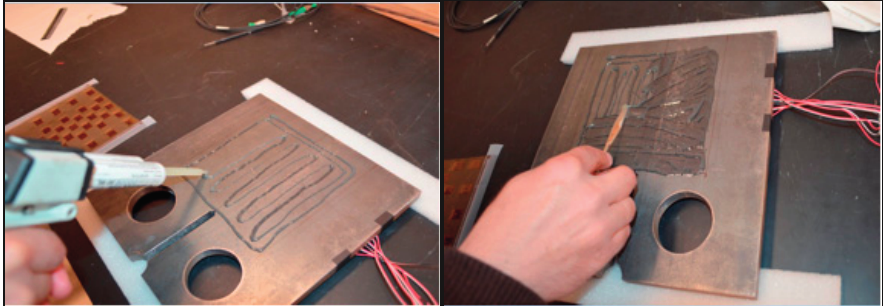
Figure 9. ( Left ): adhesive was applied onto the steel plate; ( Right ): adhesive was spread and excess removed.